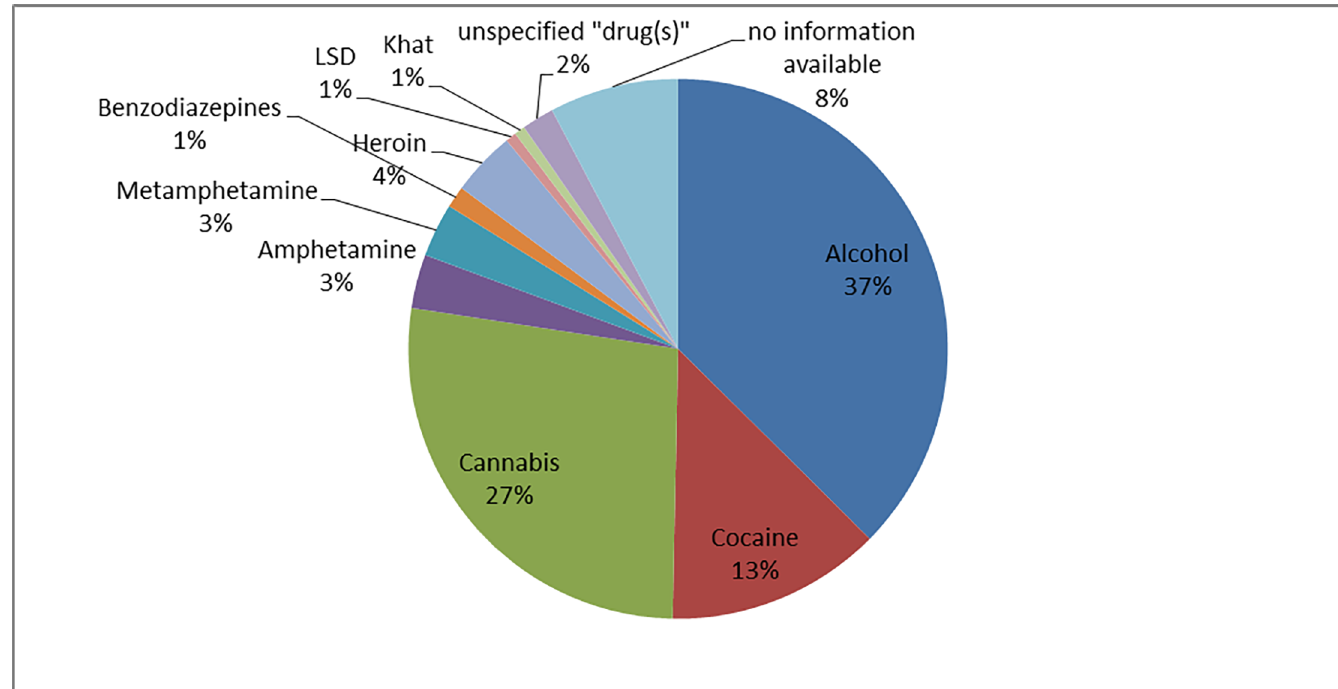
Fig 6. Reported substance use in cases of urban violence (n = 86).